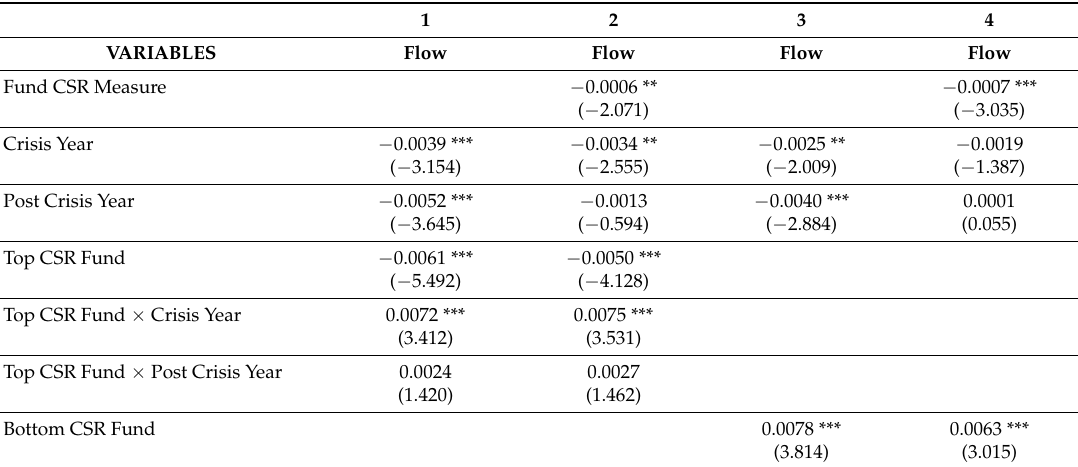
Table 5. CSR-funds and new investments: pre-crisis, crisis and post-crisis subsample analysis. 1